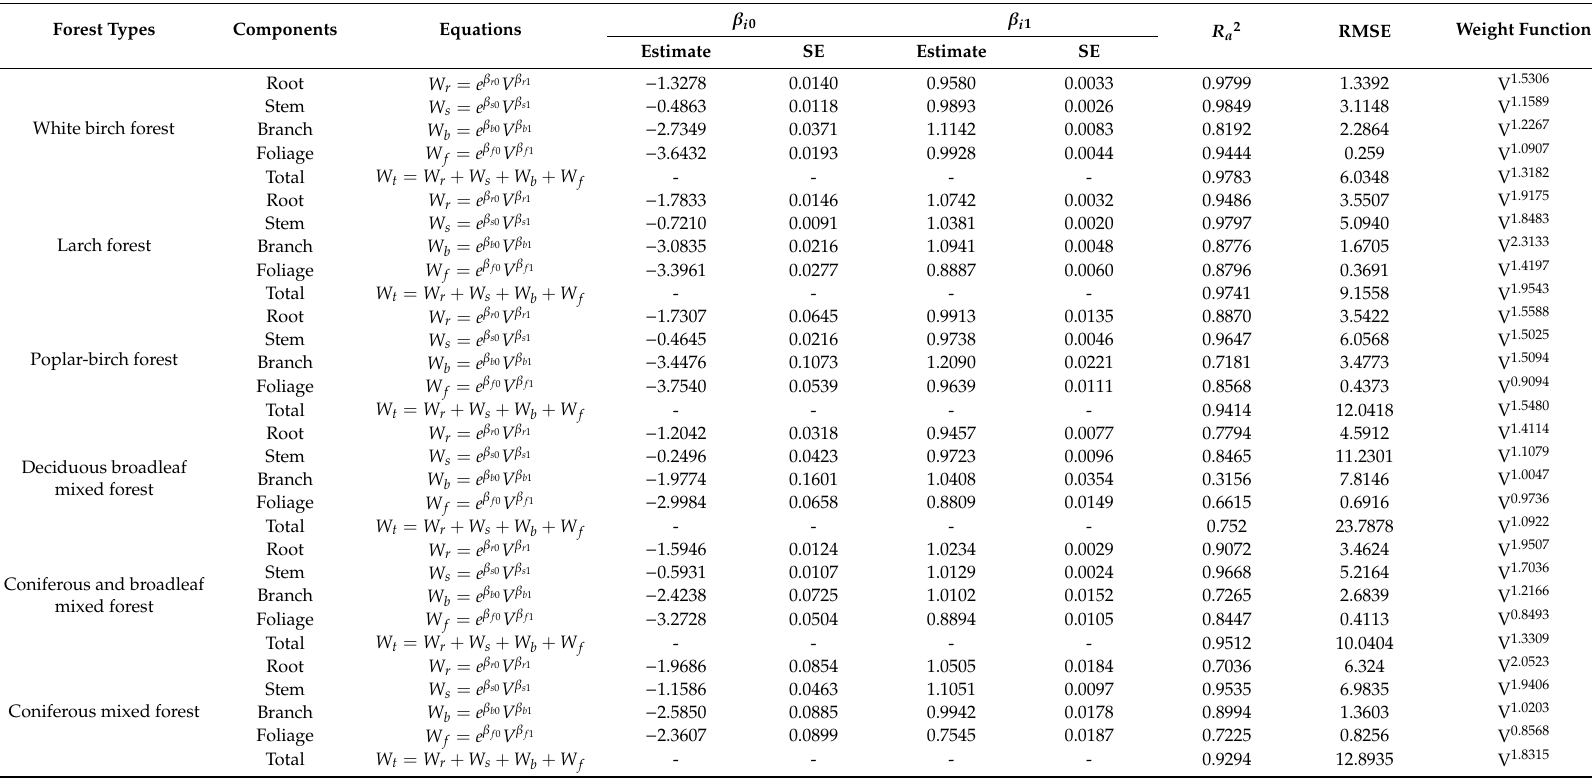
Table 4. Model coe ffi cient estimates, standard errors (SEs), model fitting statistics, and weight functions for the additive system of stand biomass equations using stand volume (namely, M-2) for the six forest types in the Eastern Da Xing’an Mountains, Northeast